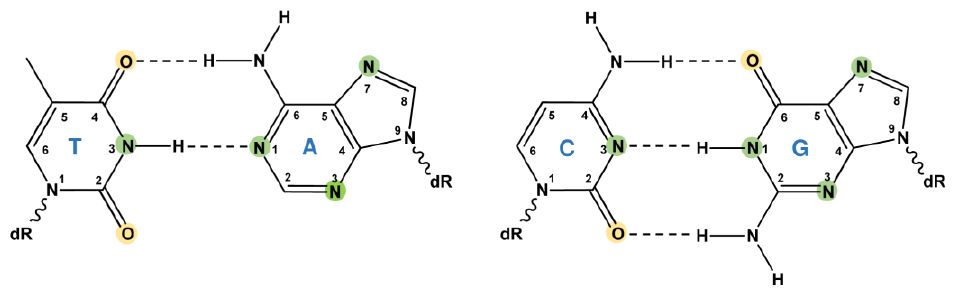
Figure 1. Alkylation of DNA bases. Alkylating agents of the S N 1-type alkylate O- and N-atoms, whereas S N 2 reagents mainly alkylate N-atoms. O-Atoms are depicted in yellow, whereas N-atoms are shown in green. dR: deoxyribose moiety.